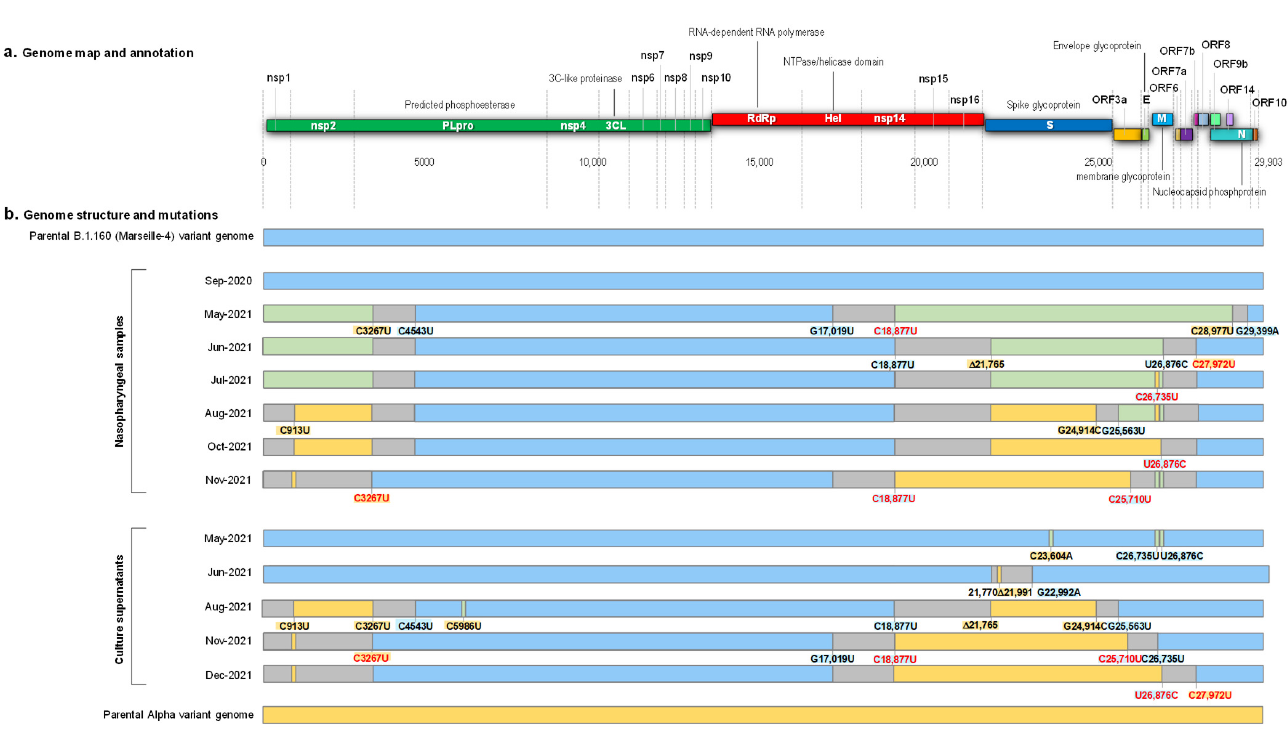
Figure 1. Schematic representation of the structure of the SARS-CoV-2 genomes obtained from the nasopharyngeal samples and from the culture supernatants, as well as of the recombination events over time, in reference to parental genomes of the B.1.160 and Alpha variants. ( a ) Genome map and annotation; ( b ) Genome structure and mutations. Blue color of rectangles indicates sequences from a B.1.160 variant; yellow color indicates sequences from an Alpha variant; green color indicates co-detection of sequences from a B.1.160 variant and from an Alpha variant; grey color indicates sequences from indeterminate origin. Signature mutations from the B.1.160 and Alpha variants are indicated by a blue background and a yellow background, respectively. Signature mutations that are absent are indicated by a red font. Δ 21,765: -6 nucleotides; Δ 21,991: -3 nucleotides. Nsp, nonstructural protein; ORF, open reading frame.